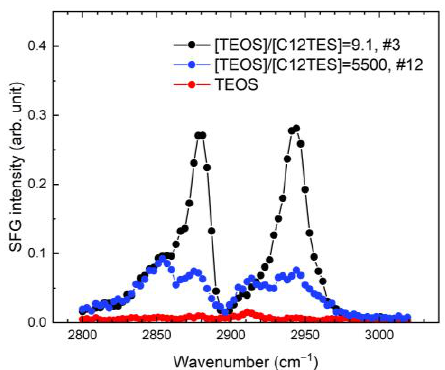
Figure 5. SSP-polarized SFG spectra of the hybrid film surfaces of [TEOS]/[C12TES] = 9.1 (#3), 5500 (#12), and TEOS-only film under dry conditions.